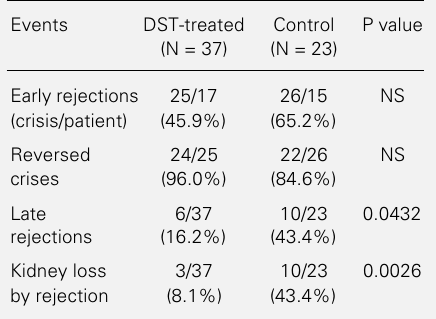
Table 2 - Evolution of DST-treated (transfused group) and control (nontransfused group) patients. NS,